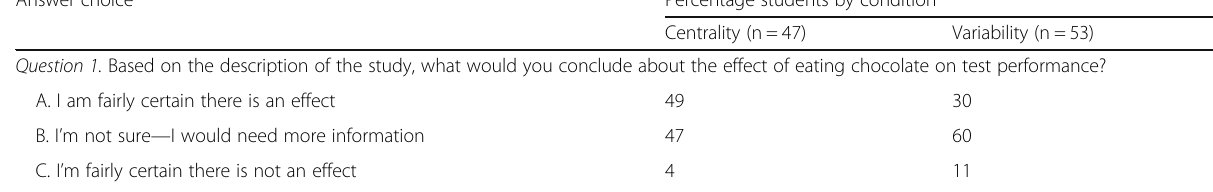
Table 2 Percentage of students selecting each answer choice for the three questions for Centrality vs. Variability gesture condition Answer